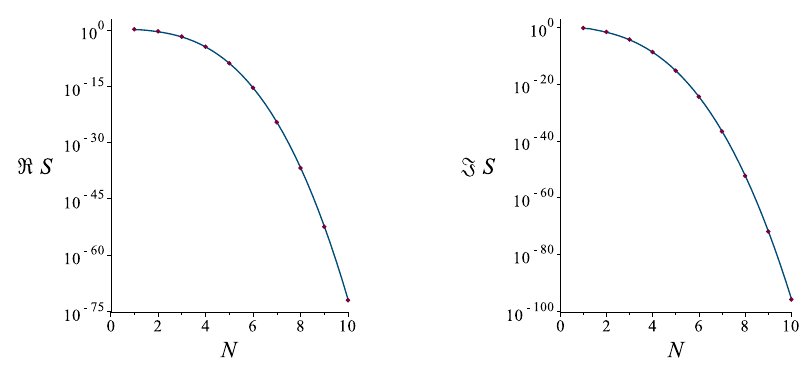
q 2 (cid:25) (red dots) with the lateral 2 g s N +1